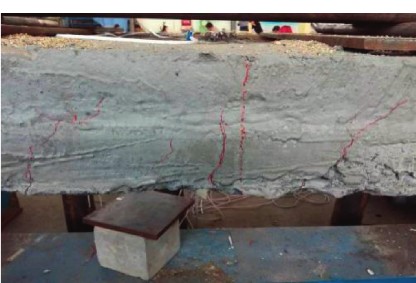
Figure 10: Fracture morphology at the edge of LPCSHTHSC specimen.